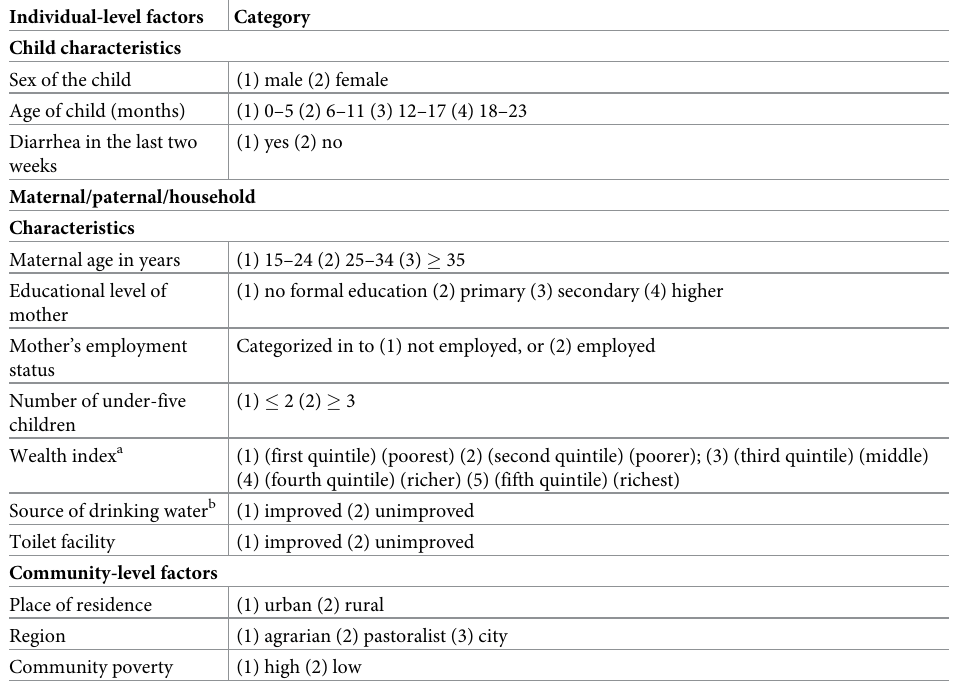
Table 1. Independent variables and